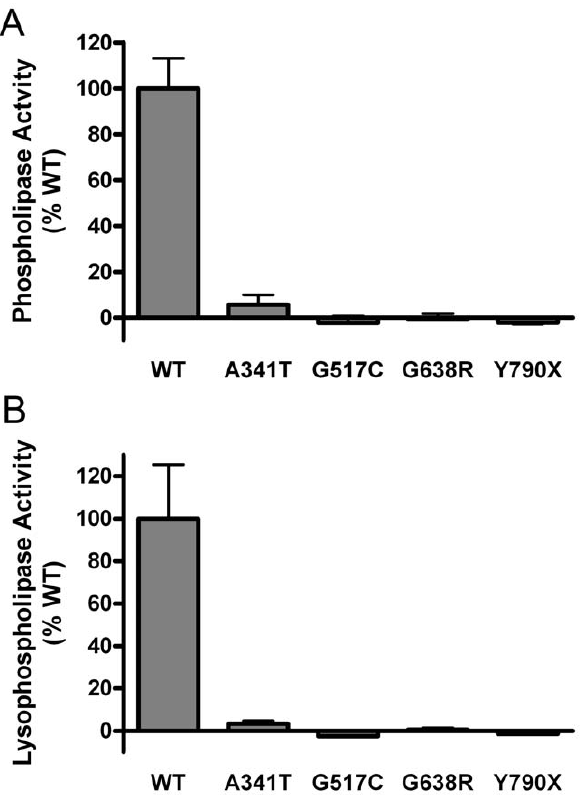
Figure 3. PLA2G6 mutations that cause NBIA/INAD significant- ly disrupt the ability of PLA2G6 to hydrolyze PC and LPC. Phospholipase and lysophospholipase catalytic activities of mutant PLA2G6 proteins were compared to wild type (WT) PLA2G6 in assays with PC and LPC substrates, respectively. Initial experiments examined the group of INAD-associated mutations A341T, G517C, G638R, and Y790X. Phospholipase (A) and lysophospholipase (B) activities are shown as percent of WT activity measured when equal concentrations of protein were added to assays measuring release of fatty acids from radiolabeled substrate. Bars indicate mean plus standard deviation (n=3) from representative experiments. The specific activities of all mutations were significantly different from WT (p , 0.05, unpaired t- test). Similar results were obtained in at least two experiments with independent transfection and purification of recombinant